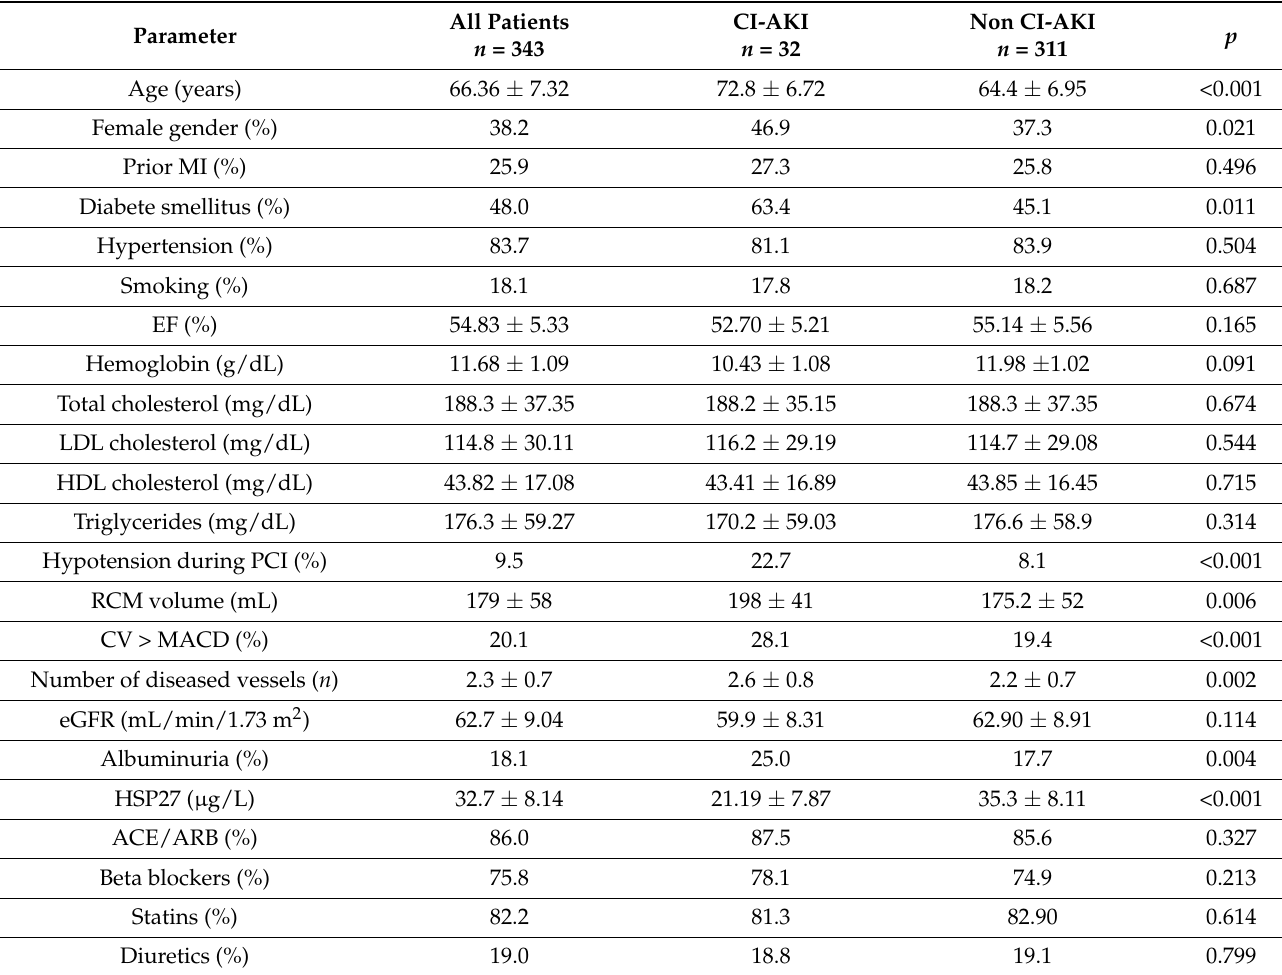
Table 1. Differences in baseline characteristic between patients with and without contrast-induced acute kidney injury (CI-AKI). All Parameter